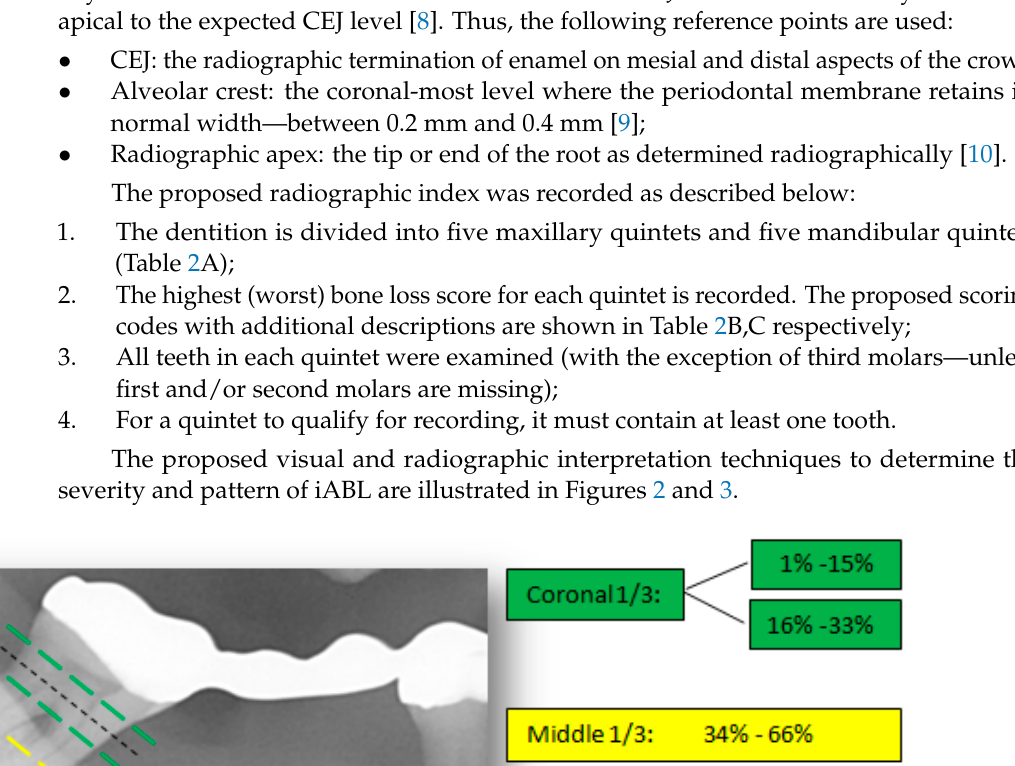
Table 1. Sample size requirement for intra-class correlation for R 0 ≠ 0 versus R 1 (R 0 = 0.5 versus R 1 = 0.7) and alpha = 0.05.